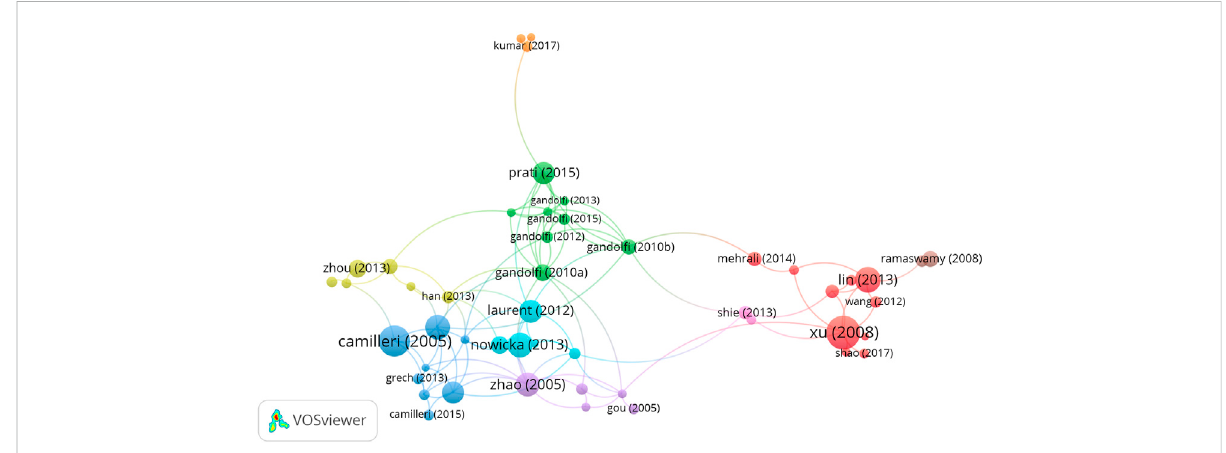
FIGURE 6 Network map of citation analysis of documents with more than sixty citations.